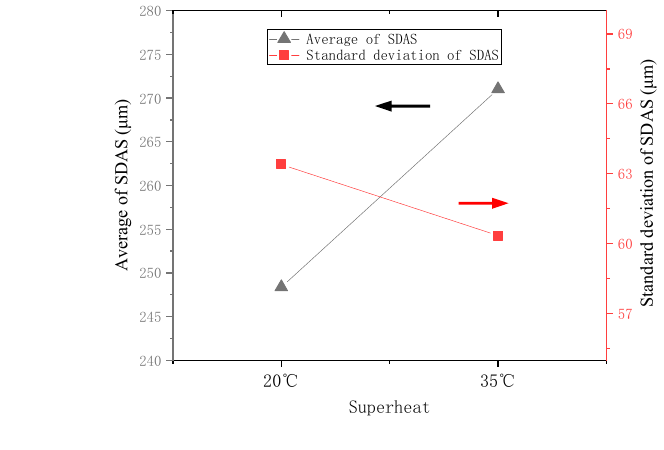
Figure 19. The average magnitude of interdendritic fluid flow velocity V if f of inner and outer curve sides at chill, middle, and central zones and average standard deviation of velocity magnitude of all sides under 20 °C and 35 °C : ( a ) average velocity magnitude, ( b ) average standard deviation.